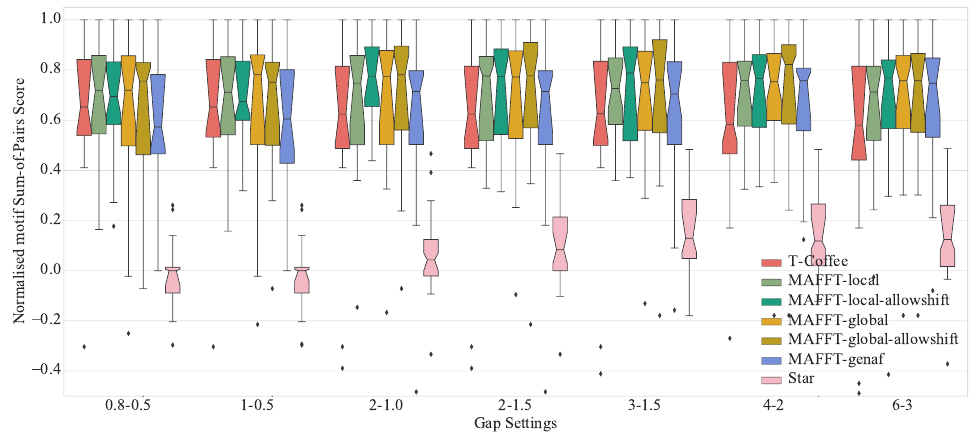
Figure 3. Normalized motif-Sum-Of-Pairs (SOP) score ( y -axis) for different gap settings ( x -axis) and Multiple Sequence Alignment (MSA) algorithms. Table 3. Median (standard deviation) normalized motif-SOP scores for different MSA algorithms and gap settings. For T-C OFFEE , the gap open values are multiplied by 10.